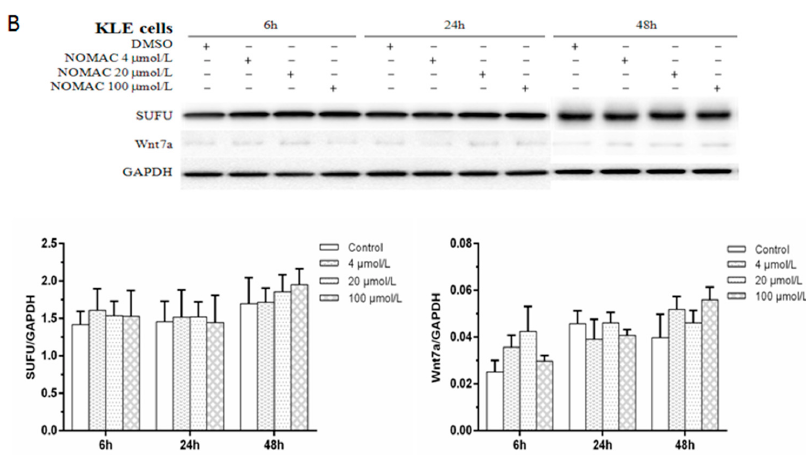
Figure 4. The effects of NOMAC on the protein levels of SUFU and Wnt7a in cultured cells (RL95-2 and KLE), as assessed by Western blotting. The relative amounts of SUFU and Wnt7a, collected from NOMAC-treated RL95-2 and KLE cells, were determined by Western blotting for the indicated times. GAPDH was used as a loading control. Cells were cultured with DMSO (control) or graded concentrations of NOMAC (4, 20, and 100 μ mol/L) for 6, 24, and 48 h. All of the results came from three independent experiments. The data were expressed as mean ± SD. ( A ) The protein expression of SUFU and Wnt7a in response to NOMAC treatment in RL95-2 cells; ( B ) NOMAC did not alter the expression levels of SUFU and Wnt7a as assessed by Western blotting analysis in KLE Cells. * p < 0.05, ** p < 0.01 relative to the control group.